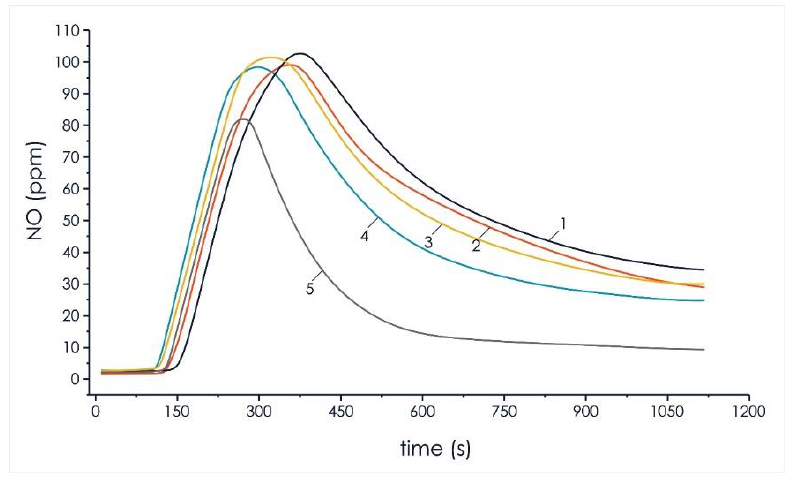
Figure 6. Analysis of nitrogen oxides concentration in the composition of volatile flue gas compounds of the investigated pellets of the initial components and mixtures based on them: 1 — 100% coal; 2 — 90% coal, 10% cedar husk; 3 — 75% coal, 25% cedar husk; 4 — 50% coal, 50% cedar husk; and 5 — 100% cedar husk.